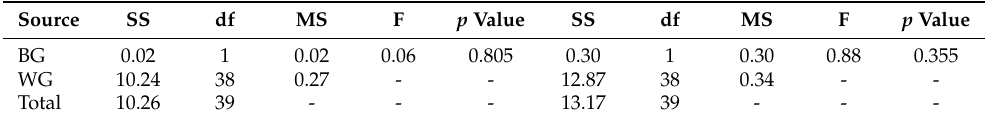
Table 7. Using the BIDMC dataset, the ANOVA results of the left side columns were obtained from the SVRMF and CASVR; the right side columns were obtained from LSTMMF and CALSTM models. Source